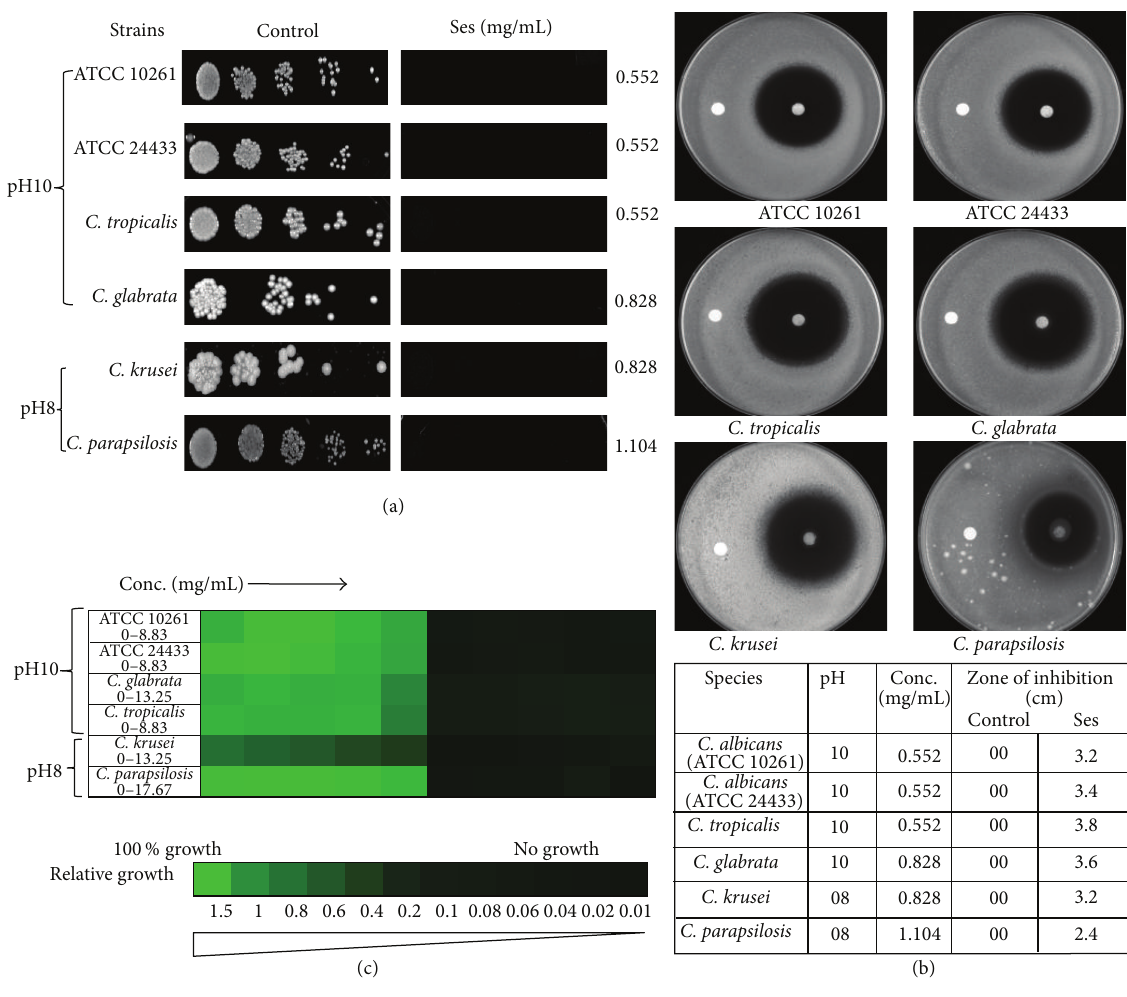
Figure 4: Drug susceptibility assay against C. albicans and non- albicans speciesat alkaline pH. (a) Spot assay of C. albicans , C. tropicalis , and C. glabrata at pH 10 and C. krusei and C. parapsilosis at pH 8 in the absence (control) and presence of Ses. (b) Disc diffusion assay against C. albicans , C. tropicalis , and C. glabrata at pH 10 and C. krusei and C. parapsilosis at pH 8 and their respective zone of inhibitions in the presence of Ses. For control discs were spotted with the solvent of Ses described in Section 2. (c) Broth microdilution assay to determine the MIC 80 at alkaline pH of C. albicans , C. tropicalis , and C. glabrata at pH 10 and C. krusei and C. parapsilosis at pH 8 in the presence of Ses. Data was quantitatively displayed with colour (see colour bar), where each shade of colour represents relative optical densities of the cell. The minimum drug concentration that inhibits growth by 80% relative to the drug-free growth control is indicated as MIC 80 for each strain. diffusion assay as well as illustrated in Figures 4(b) and 4(c). Table 2: MIC of C. albicans and non- albicans in presence of Ses at 80 alkaline